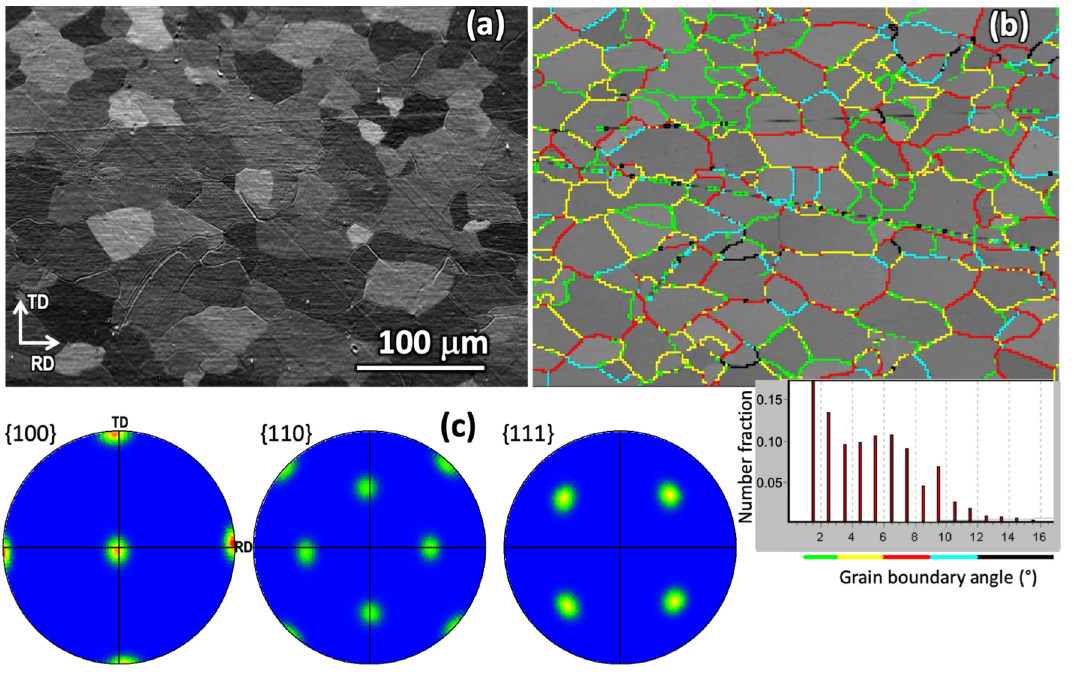
Figure 2. EBSD characterization results of the Ni5W tape before laser irradiation: ( a ) FSD image. ( b ) Grain boundary map of the same sample (identical location and magnification). Colors represent different misorientation angle ranges between adjacent grains as indicated in the histogram below the figure. ( c ) {100}, {110} and {111} pole figures calculated from EBSD measurements of the same sample. RD and TD refer to the rolling direction and transverse direction, respectively.